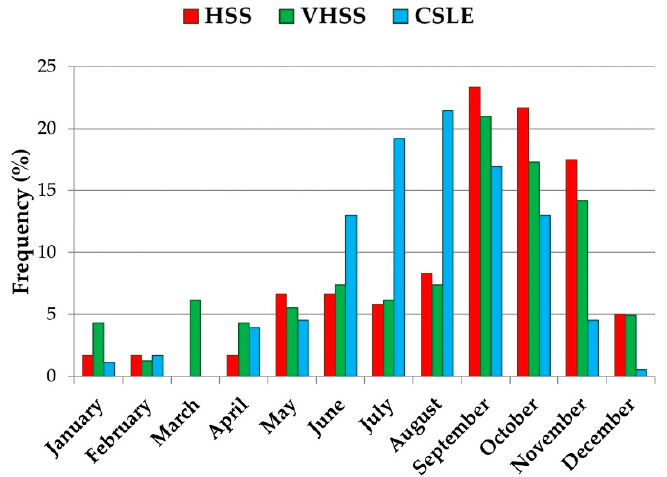
Figure 7. Monthly frequency histograms of HSS, VHSS and CSLE.